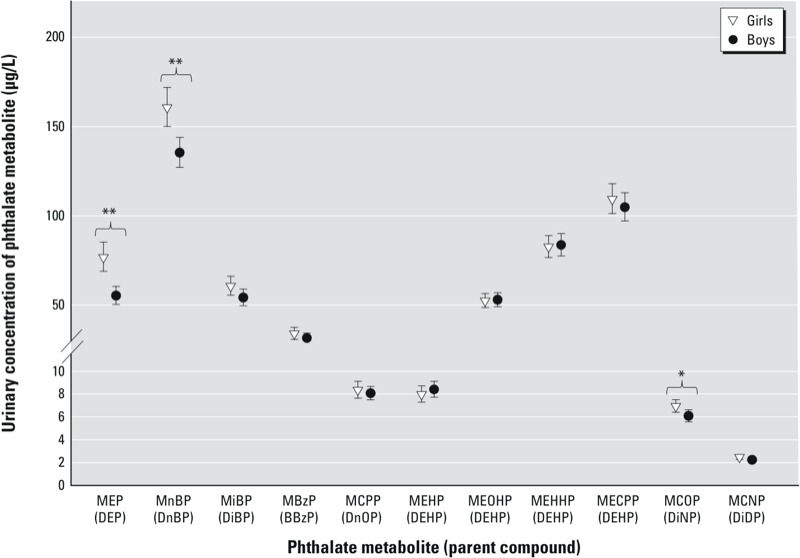
SG-adjusted phthalate metabolite concentrations (µg/L) in girls and boys. Values are GM with error bars for 95% CIs. *p < 0.05. **p< 0.001.